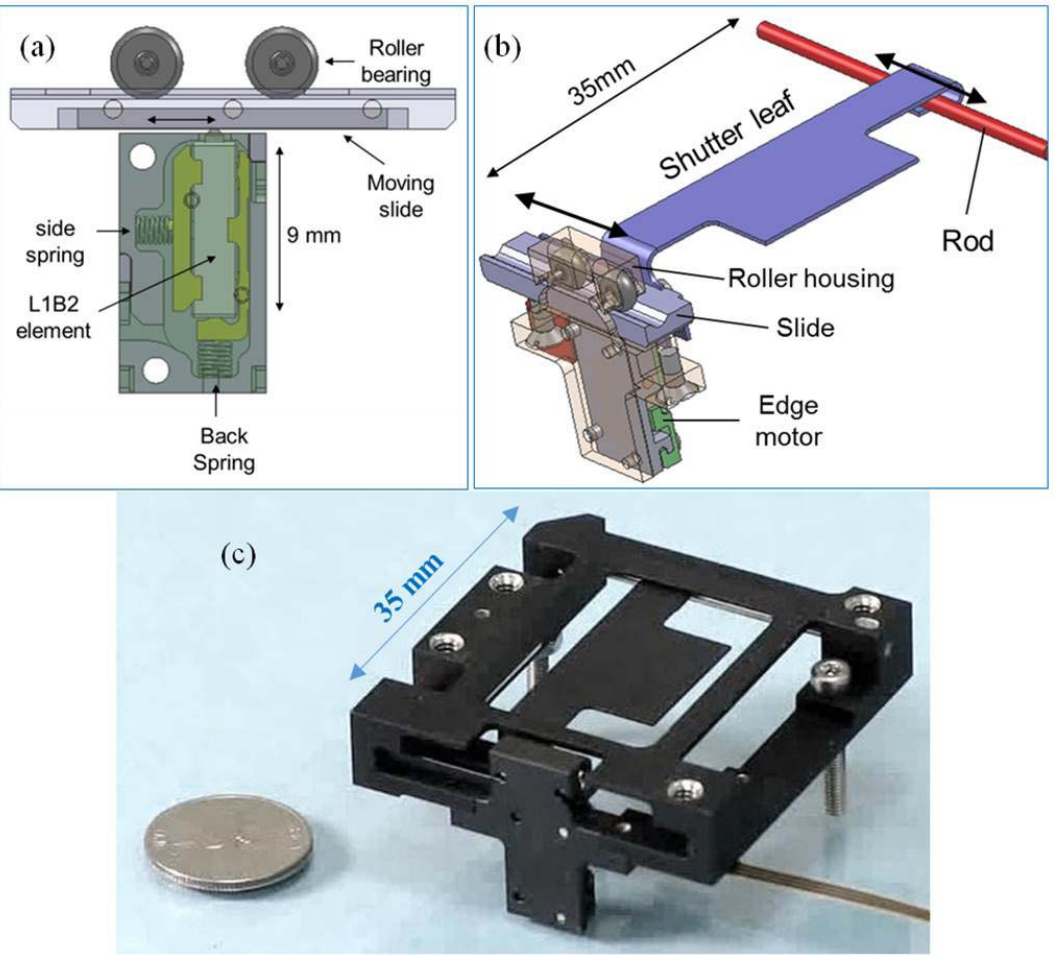
Figure 15. Linear NUC shutter based on Nanomotion Edge L1B2 motor: ( a ) Schematic drawing of the Edge motor preloaded onto the drive strip. ( b ) Schematic drawing of the leaf motion mechanism. ( c ) Image of the linear NUC shutter.